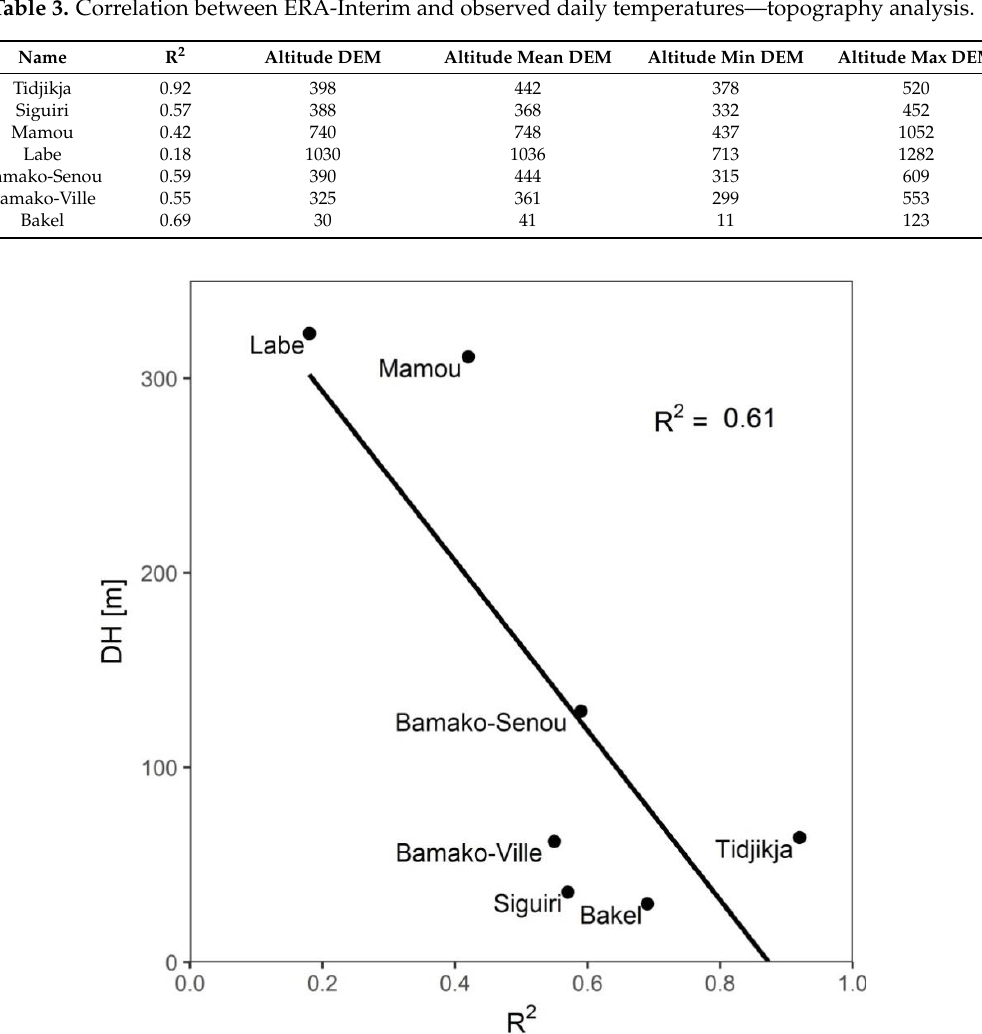
Figure 4. Relation between R 2 (of observed temperature vs. ERA-Interim) and DH.